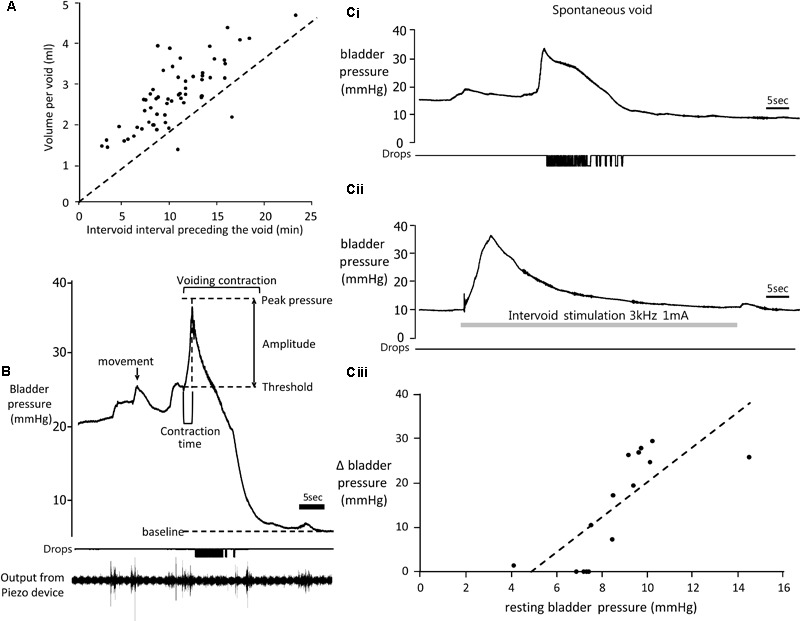
(A) Relationship between voided volume and inter-void interval (time elapsed since the previous void). Broken line shows expected voided volume based solely on volume of saline infused over same time period. Data from six rats. (B) Top trace: Example of change in bladder pressure during a void induced by infusion of saline into the bladder. Trace annotated to show urodynamic measurements made. Middle trace: timing of drops of urine voided. Lower trace: output from the piezo device detecting gross movements of the animal. (Ci) Change in bladder pressure during a spontaneous void during infusion of saline into the bladder (11.2 ml/h). (Cii) Effect of stimulation of the pelvic nerve (gray panel, 3 kHz 1 mA) in the same rat during the interval between voids. (Ciii) Relationship between amplitude of the response to pelvic nerve stimulation and resting bladder pressure (data from six rats).